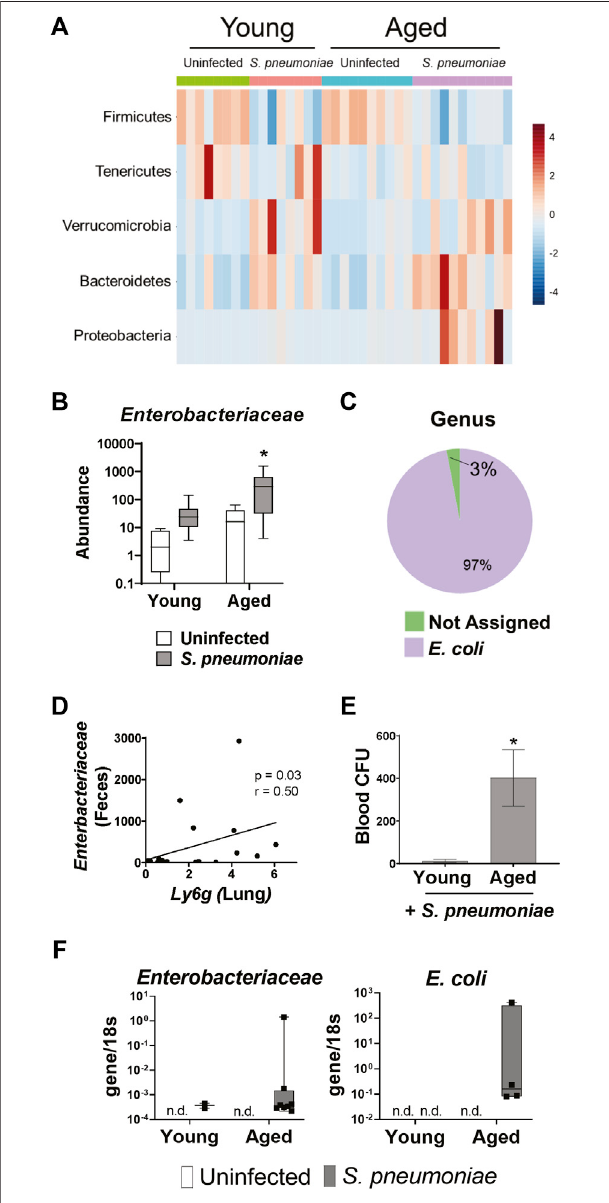
FIGURE 5 | S. pneumoniae infection induces an age-speci fi c rise in Enterobacteriaceae. (A) Heat map illustrating the relative abundance of the top fi ve bacterial phyla in the feces of young and aged mice. (B) Bar graph showing mean abundance of Enterobacteriaceae in the feces from the indicated